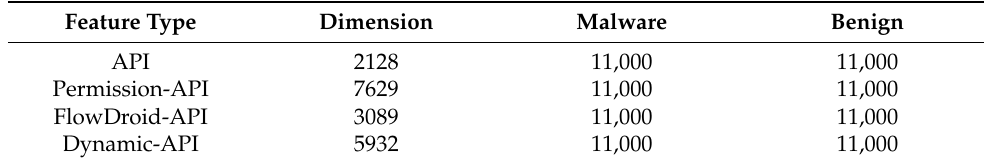
Table 1. OmniDroid [14] dataset features and